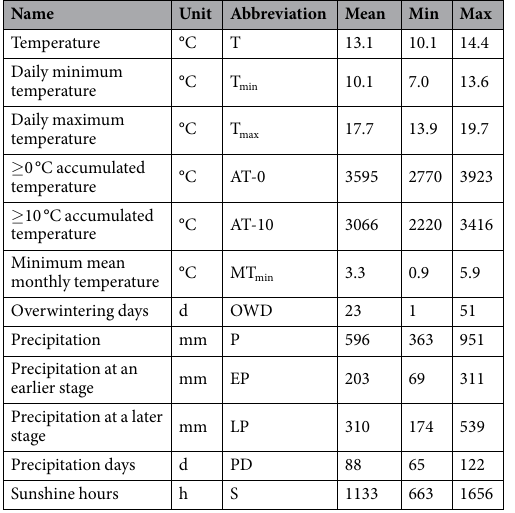
Table 1. Description of the twelve agroclimatic indices for winter oilseed rape.